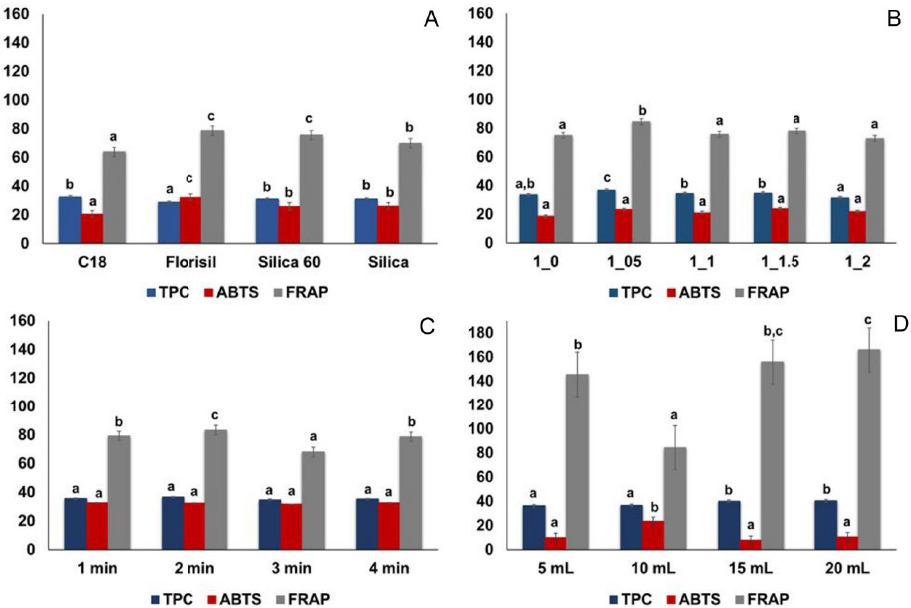
Figure 1. Influence of extraction parameters: ( A ) selection of stationary phase (adsorbent); ( B ) ratio of sample to adsorbent (S/A ratio); ( C ) time of vortexing and ( D ) ratio of sample to extraction solvent on the: TPC (mg GA/g DW); ABTS (mg TE/g DW) and FRAP (mg Fe 2+ /g DW) for the H. arenarium extracts obtained by the NADES-VA-MSPD extraction method. Different superscripts for the same variable indicate a statistically significant difference at the 95% confidence level ( p < 0.05) according to the S-N-K